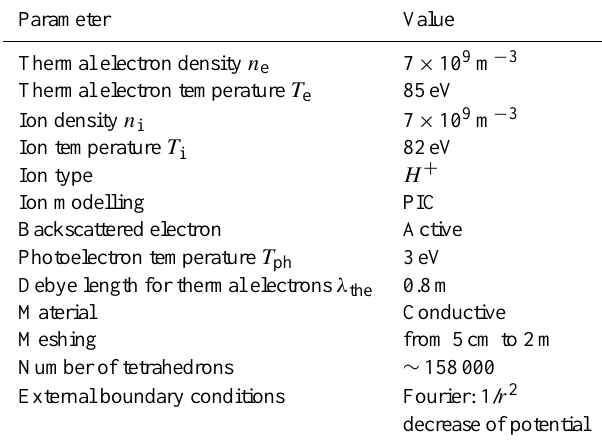
Table 3. Parameters used for the nominal simulation